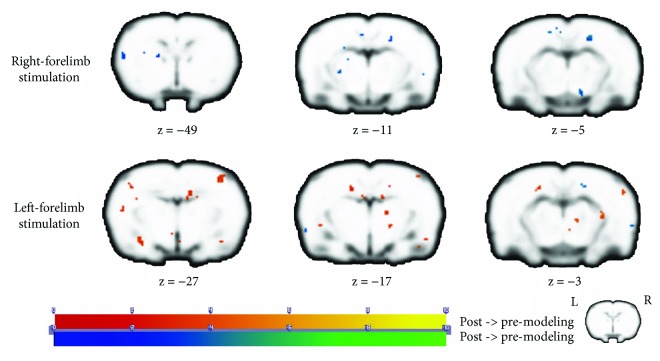
Group differences of activation in block-design scan. The first row in the figure displays results of the right forelimb stimulation task, and the second row displays results of the left forelimb stimulation task. The warm tone represents activation of postmodeling greater than premodeling, whereas the cold tone represents activation of postmodeling weaker than premodeling. Z-value was the z-axis coordinate along the anterior-posterior axis referenced to a stereotaxic rat brain MRI template [69] which has been aligned with the coordinates of Paxinos and Watson's.